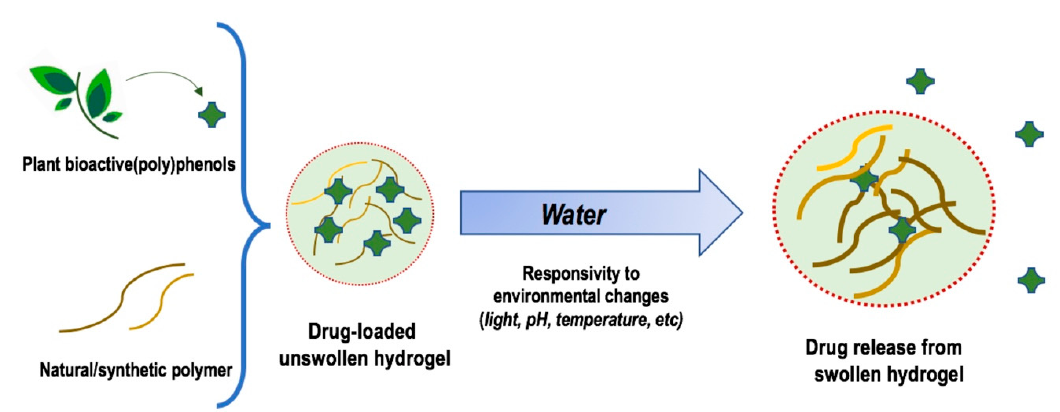
Figure 1. (Poly)phenol-loaded hydrogels as smart drug delivery systems .